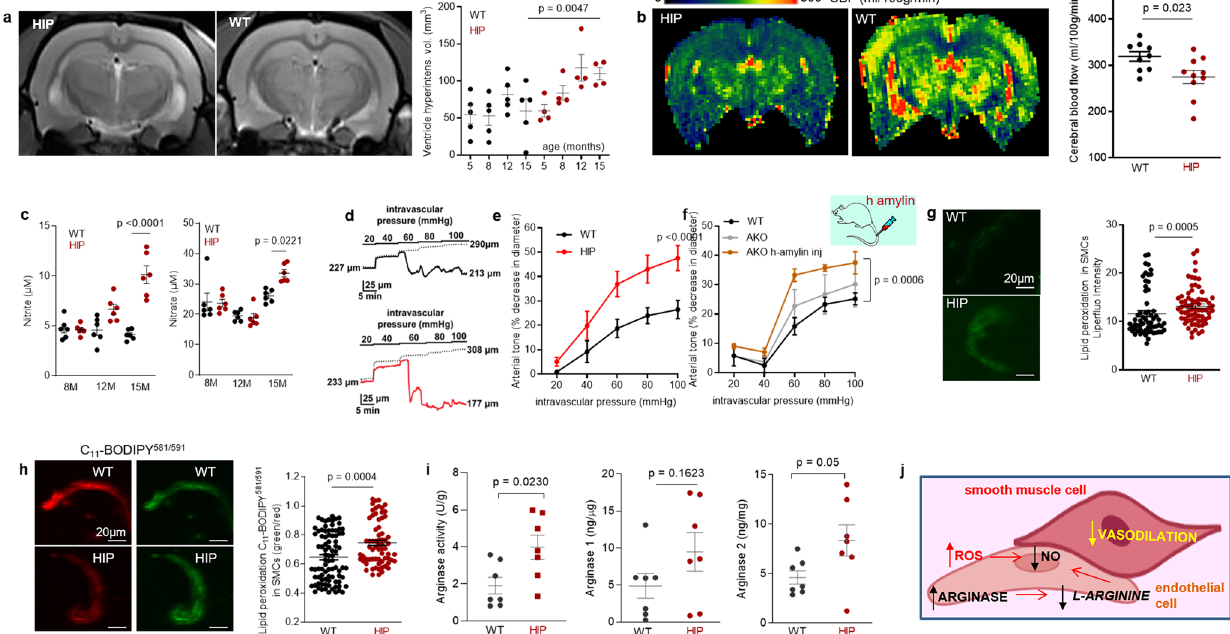
Fig. 4 Altered relaxation of vascular smooth muscle cells by increased blood amylin concentrations. a T 2 -weighted MRI and longitudinal ventricular hyperintensity volumes in HIP vs. WT rats ( n = 4 – 5 males/group). b CBF maps and global CBF in HIP and WT rats, age 15-16 months (9 males/group). c Cross-sectional concentrations of plasma nitrite and nitrate in HIP and WT rats ( n = 6 males/group/age). Diameter traces in pial arteries from HIP and WT rat males at different intravascular pressures ( d ), and arterial tone of pial arteries ( e ) measured at the indicated intravascular pressure (2 – 3 arteries/ rat, n = 6 – 7 males/group, age 15 – 16 months). f Same as in ( e ) in posterior cerebral arteries from WT and amylin knockout (AKO) rats, and in AKO rats intravenously injected with human amylin ( n = 3 males/group, age 9 – 10 months). g , h Lipid peroxidation in pial artery SMCs from WT and diabetic HIP rat males measured with Liper fl uo ( g ; N = 62 SMC from 4 WT rats and 70 cells from 4 HIP rats) and C 11 -BODIPY 581/591 ( h ; N = 87 SMC from 7 WT rats and 68 cells from 4 HIP rats). i Arginase activity and arginase-1 and arginase-2 concentrations in HIP vs. WT brain microvessel lysates ( n = 7 males/group; age 15 – 16 months). j Proposed mechanism: chronically increased concentrations of pancreatic amyloid-forming amylin in blood cause oxidative stress within the vascular wall leading to NO-arginase dysregulation and impaired SMC function and myogenic tone. Data are means ± SEM. Mann – Whitney non- parametric test for panels ( g , h ), unpaired t -test for the other panels.